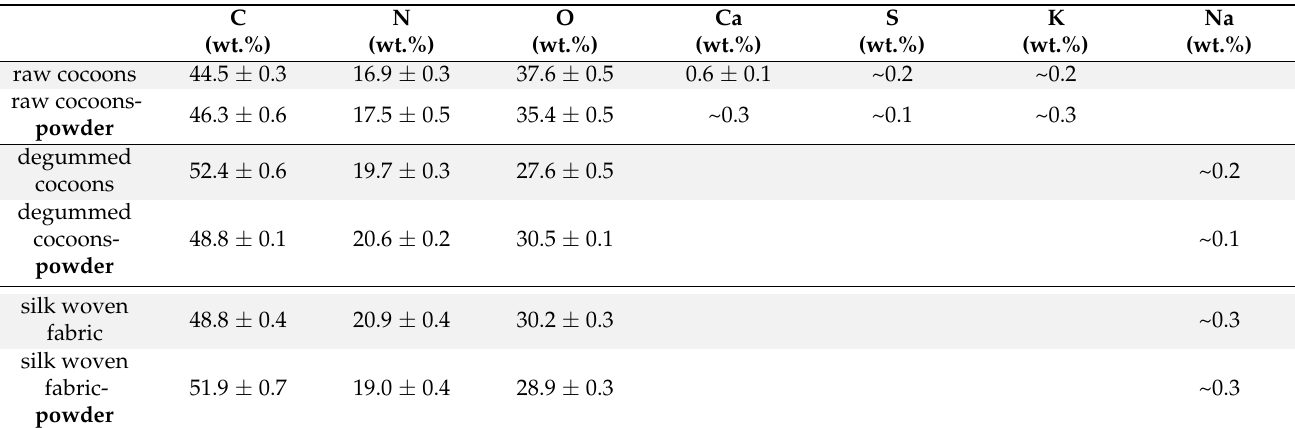
Table 1. Results of EDS analysis of raw silk cocoons, degummed cocoons, silk fabric, and their